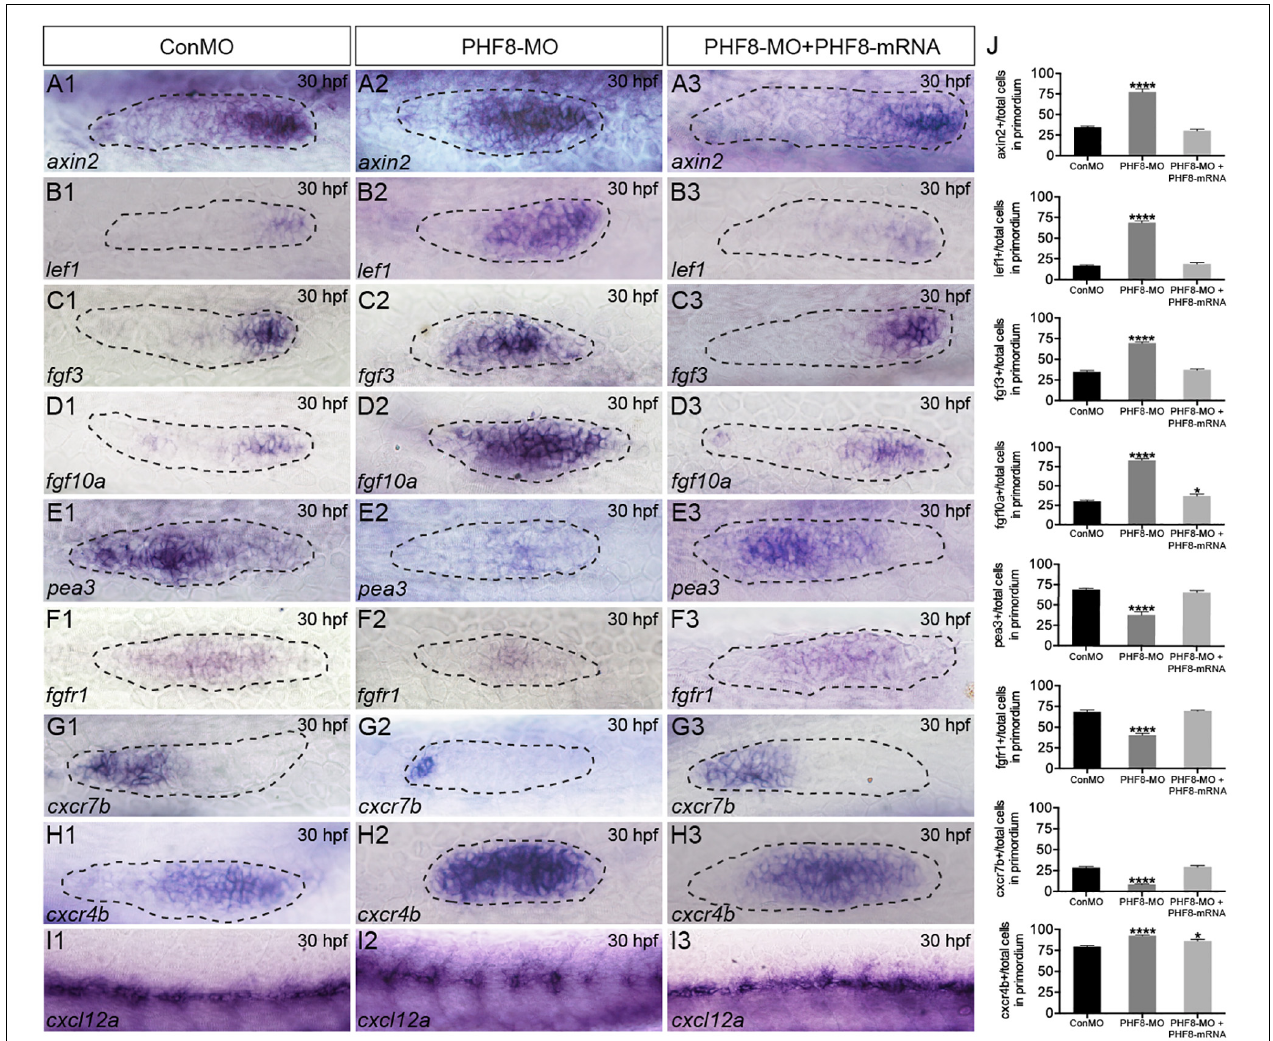
FIGURE 5 | Analysis of expression of genes of Wnt and FGF signaling pathways, as well as cxcl12/cxc7b/cxcr4b . (A–I) WISH was utilized to examine the expression of axin2 (A) , lef1 (B) , fgf3 (C) , fgf10a (D) , pea3 (E) , fgfr1 (F) , cxcr7b (G) , cxcr4b (H) , and cxcl12 (I) at 30 hpf. (J) The ratio of axin2 , lef1 , fgf3 , fgf10a , pea3 , fgfr1 , cxcr7b , and cxcr4b -positive cells to total cells in the primordia of controls (ConMO; n = 10 embryos for axin2 , 10 embryos for lef1 , 12 embryos for fgf3 , 12 embryos for fgf10a , 11 embryos for pea3 , 9 embryos for fgfr1 , 10 embryos for cxcr7b , 12 embryos for cxcr4b ), PHF8 morphants (PHF8-MO; n = 10 embryos for axin2 , 10 embryos for lef1 , 14 embryos for fgf3 , 17 embryos for fgf10a , 9 embryos for pea3 , 9 embryos for fgfr1 , 15 embryos for cxcr7b , 17 embryos for cxcr4b ), and PHF8-MO co-injected with PHF8-mRNA embryo (PHF8-MO + PHF8-mRNA; n = 10 embryos for axin2 , 10 embryos for lef1 , 10 embryos for fgf3 , 9 embryos for fgf10a , 9 embryos for pea3 , 10 embryos for fgfr1 , 12 embryos for cxcr7b , 12 embryos for cxcr4b ). Data are expressed as mean ± SEM. * p < 0.05, **** p < 0.0001. All optical appearances elucidate lateral visions; anterior is on the left. The primordium is delineated with a dashed